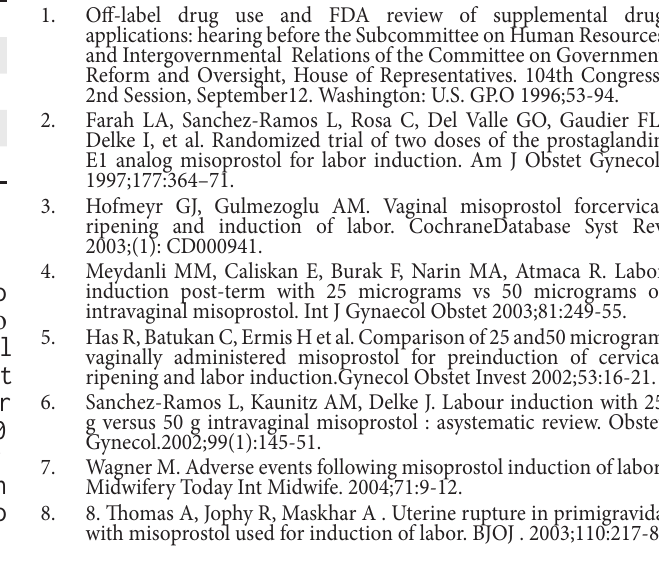
Table 3 : Fetal outcome analysis